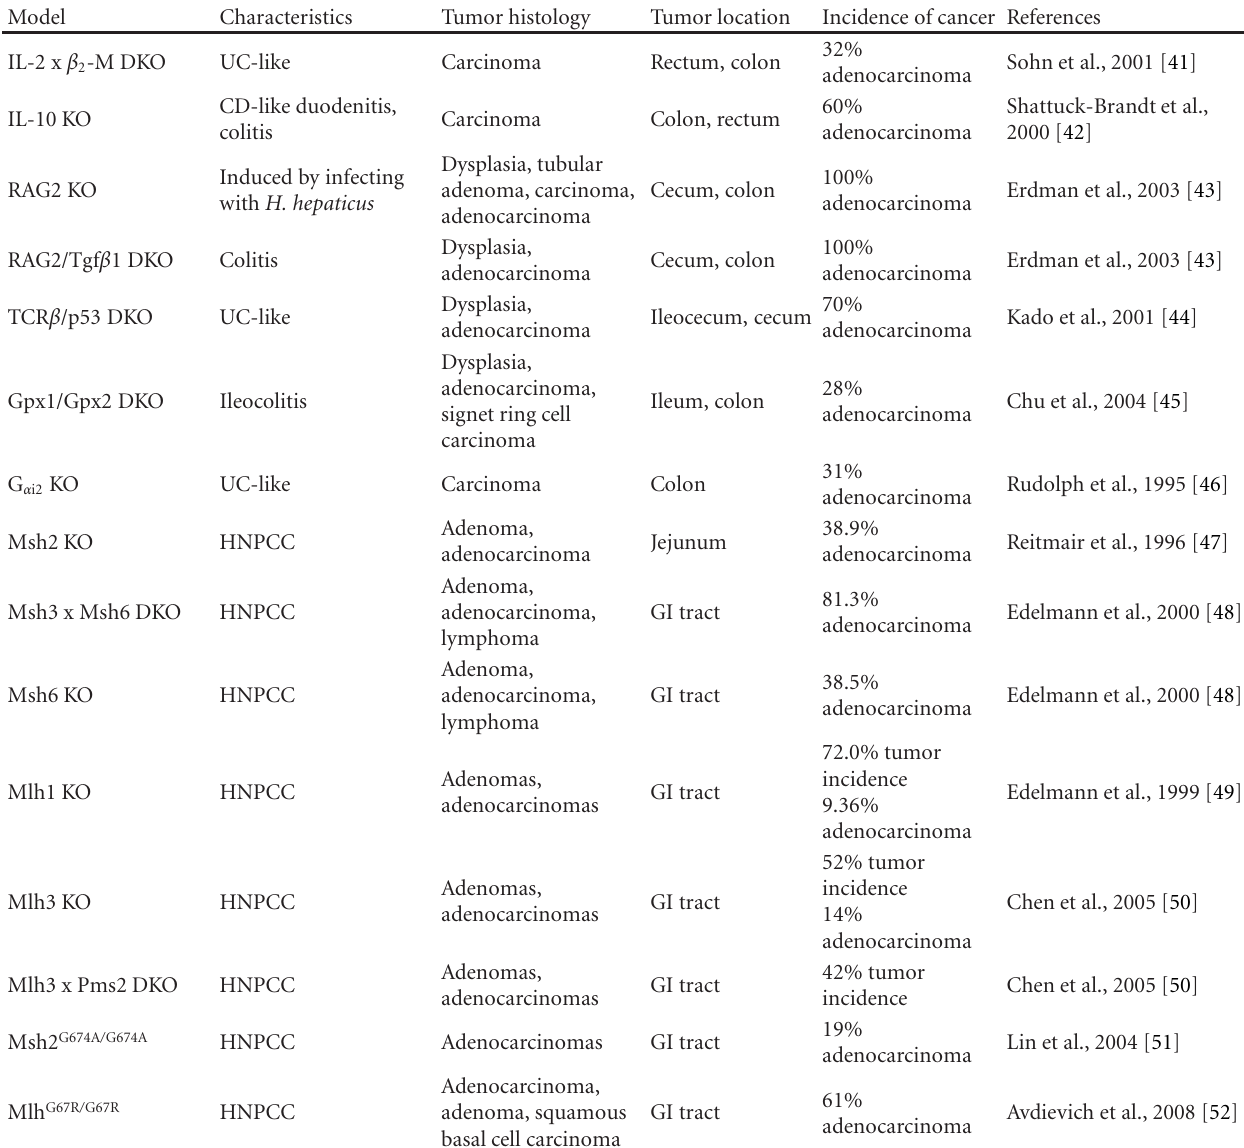
Table 1: Summary of CAC in genetically engineered animal models of